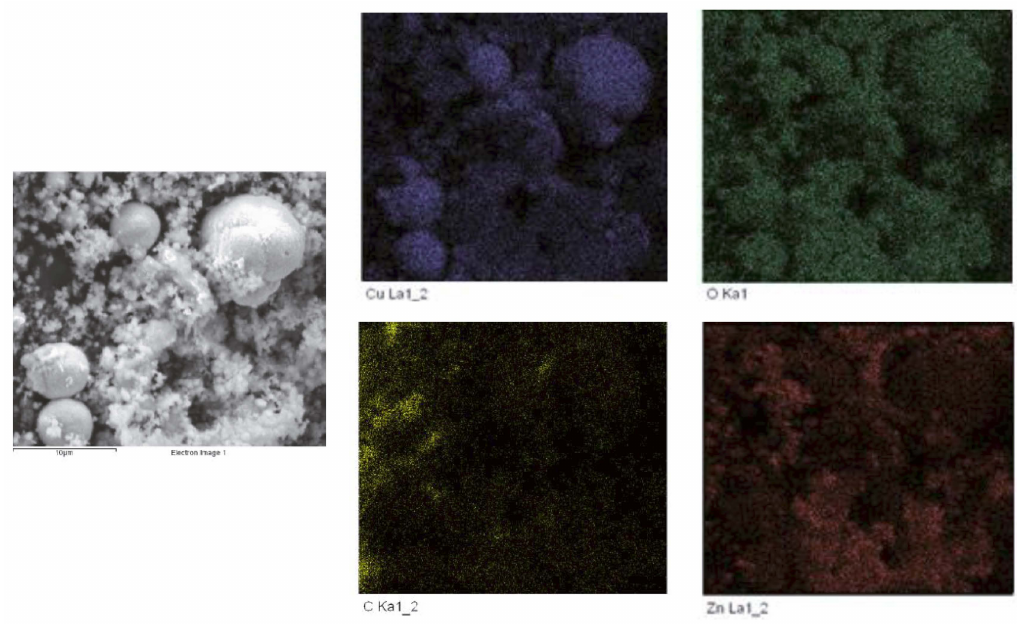
Figure 8. SEM-EDX elemental mapping of scale collected at the end of